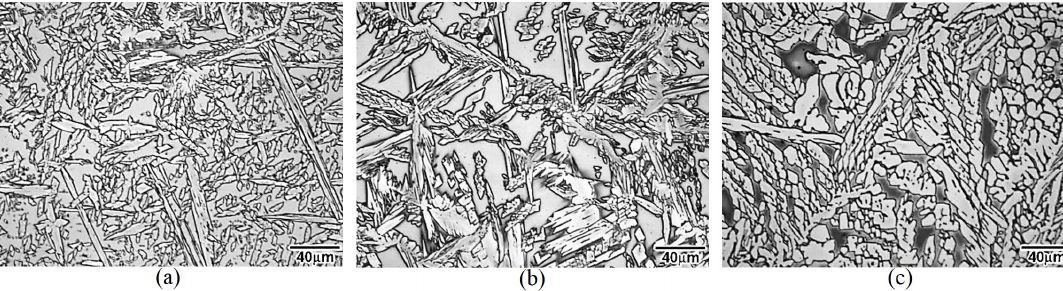
Figure 6. Microstructure of the molten zone (MZ). (a) 0.5 kJ.mm -1 with a ferrite content of 70% (matrix) and acicular austenite precipitation; (b) 1.0 kJ.mm -1 with a ferrite content of 63% (matrix) and acicular austenite precipitation; (c) 3.5 kJ.mm -1 with a ferrite content of 54% (matrix) and coarser acicular austenite precipitation. OM, electrolytic etching in KOH